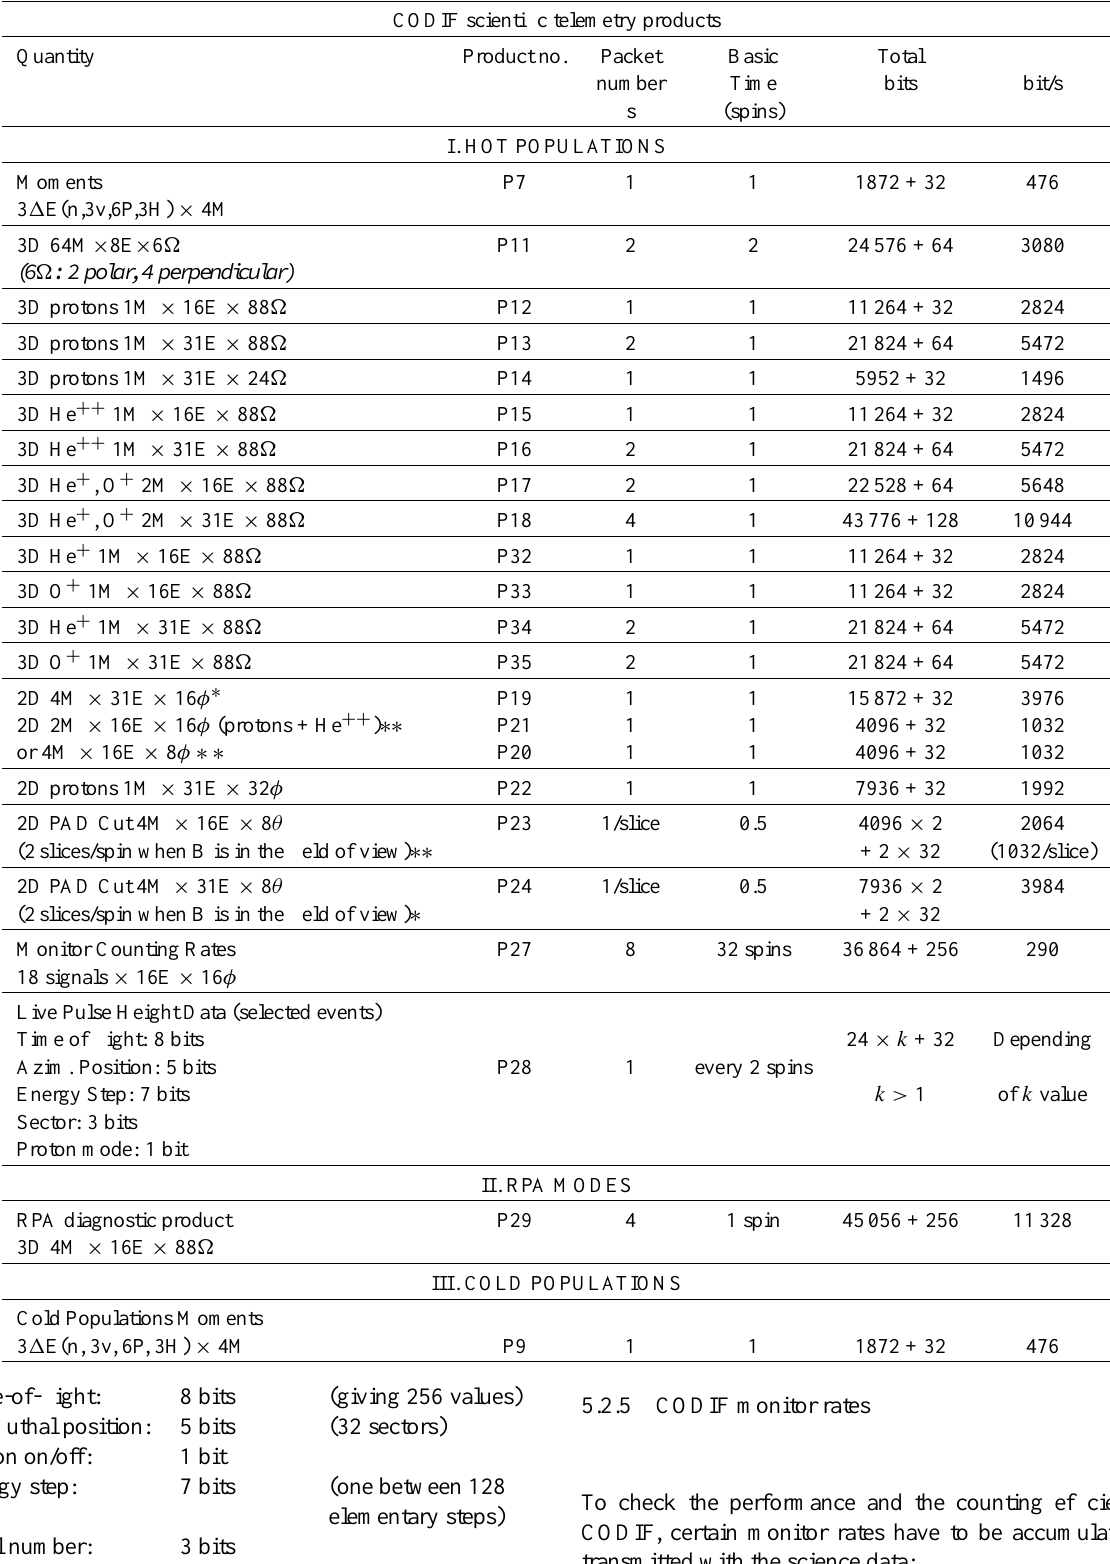
Table 6. CODIF scientific telemetry products